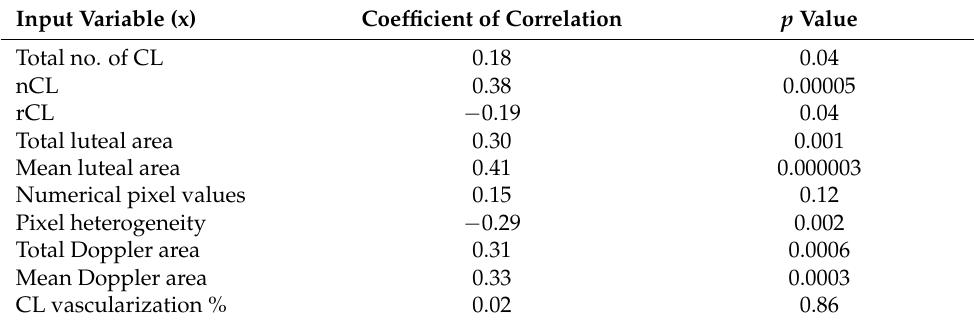
Table 2. Summary of overall correlations (Pearson product-moment) of CL biometric, echotextural, and Doppler parameters (input variables) with serum progesterone (P 4 ) concentrations (output variable) in Santa In ê s ewes superovulated with 100, 133, or 200 mg of pFSH administered in eight decreasing doses, during the period spanning Day 11 (1 or 2 days after ovulation or beginning of luteogenesis) to Day 15 (day of embryo recovery). Input Variable (x) Coefficient of Correlation p Value Total no. of CL 0.18 0.04 0.38 0.00005